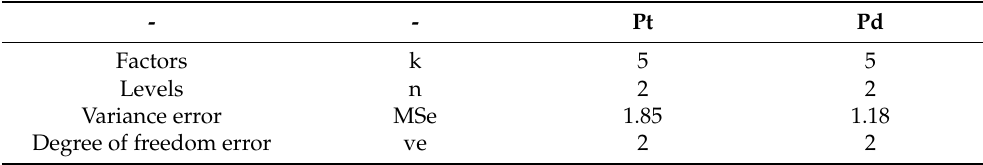
Table 3. Summary of important parameters.